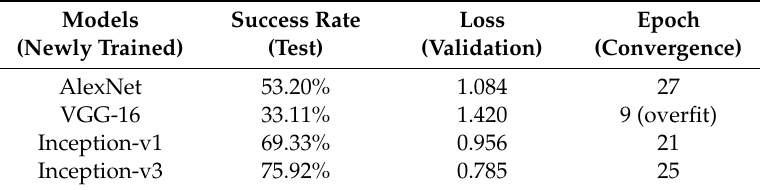
Table 2. Performance of various convolutional neural networks (CNNs) newly trained on the dataset without data augmentation.